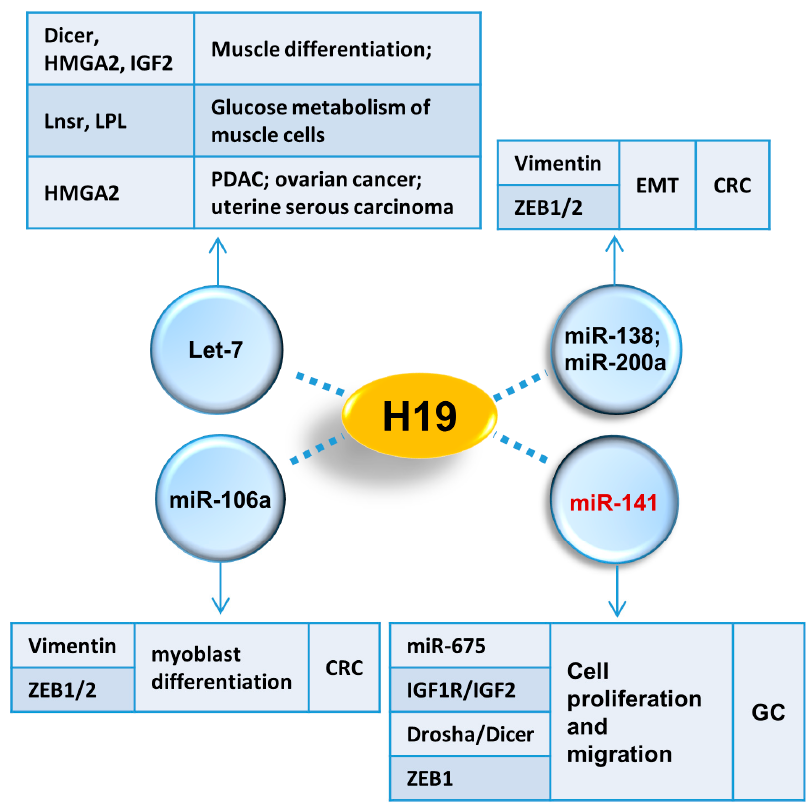
Figure 2. H19 interactive miRNAs. Different associated miRNAs of H19 are demonstrated. These four miRNAs are involved in several kinds of cancers and development via targeting functional factors as indicated in tables. In GC, H19 associates with miR-141 and further affects downstream targets: miR-675, IGF1R, IGF2, Drosha, Dicer and ZEB1. EMT, epithelial–mesenchymal transition; CRC, colorectal cancer; GC, gastric cancer.